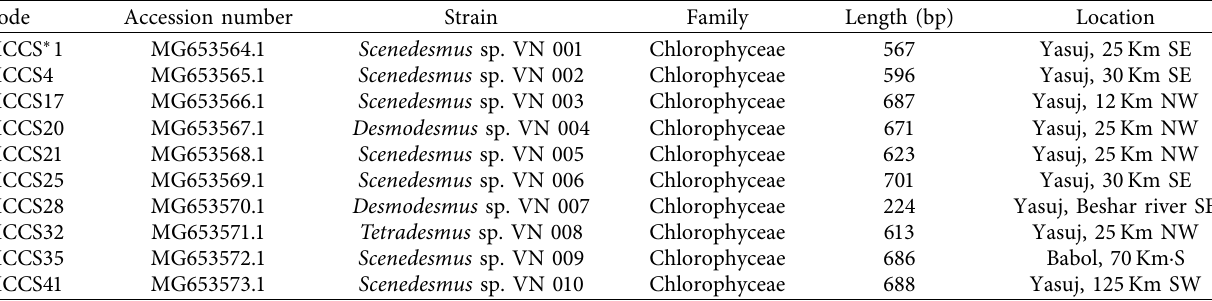
Table 2: Accession numbers for 18S rRNA gene sequence, strain, family, length in base pairs, and location for ten microalgal isolates. Code